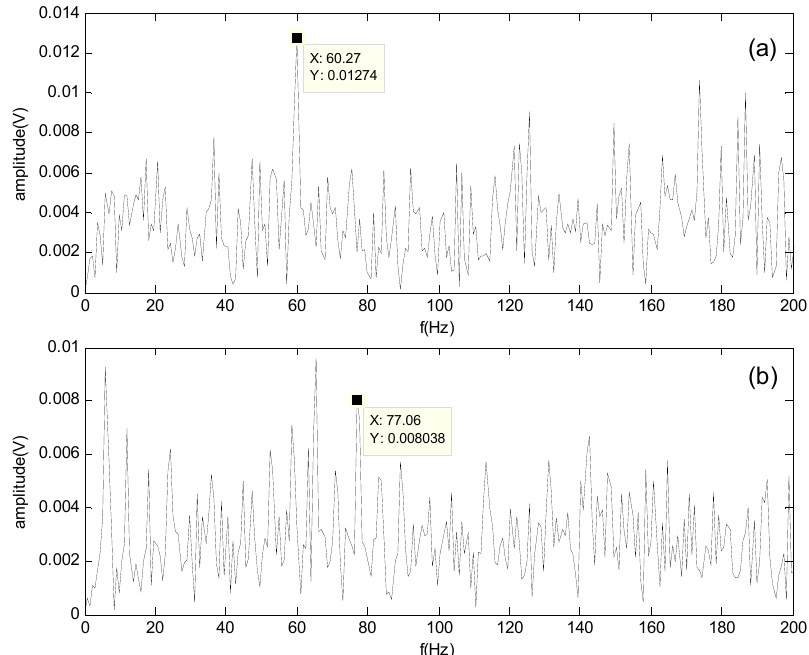
Figure 14. Spectrum of the separated noisy signals by ensemble empirical mode decomposition (EEMD): ( a ) Spectrum of the outer-race defect; ( b ) Spectrum of the roller defect.